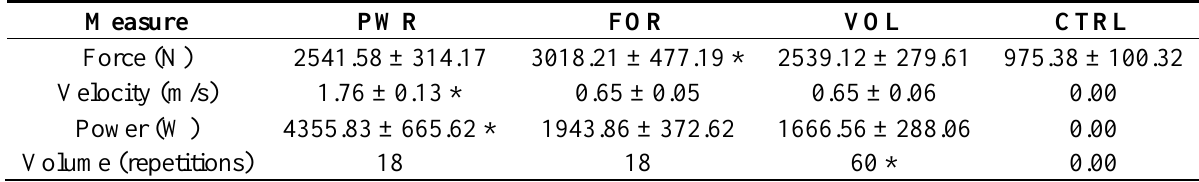
Table 2. Average physical characteristics of each protocol. Protocols were designed to produce maximal values for the biomechanical property of interest. * Significantly greater than all other protocols. (The CTRL protocol was not included in the analysis).